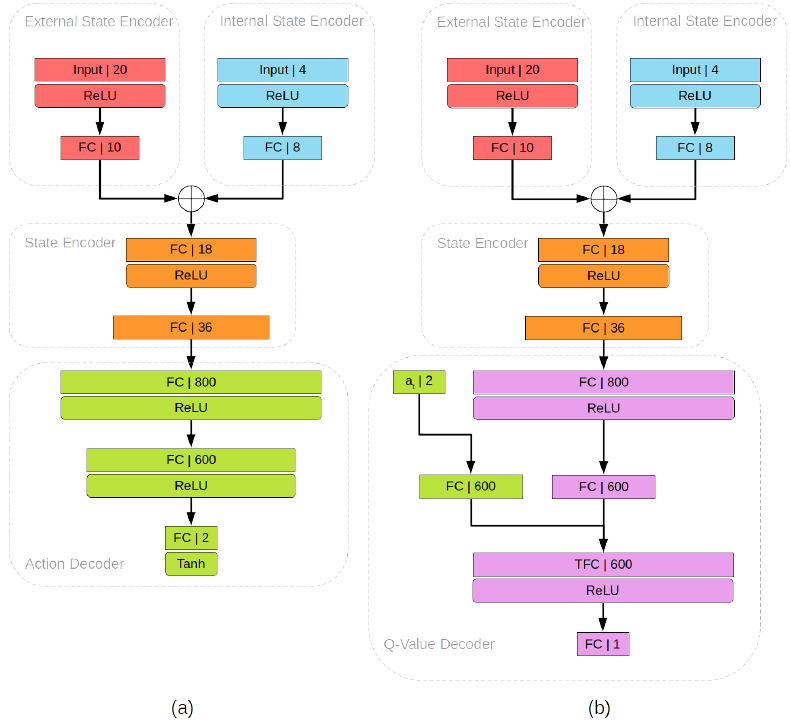
Figure 2. ( a ) Visualization of Actor Network architecture in TD3. ( b ) Visualization of Critic Net- work Architecture in TD3. FC represents a fully connected layer, numbers represent the out- put parameters of the respective layer, TFC represents the transformation fully connected layer, (cid:76) represents